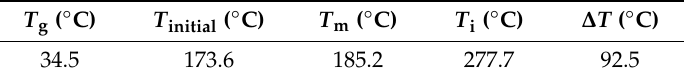
Table 2. DSC data of PSCTLCP in nitrogen atmosphere.